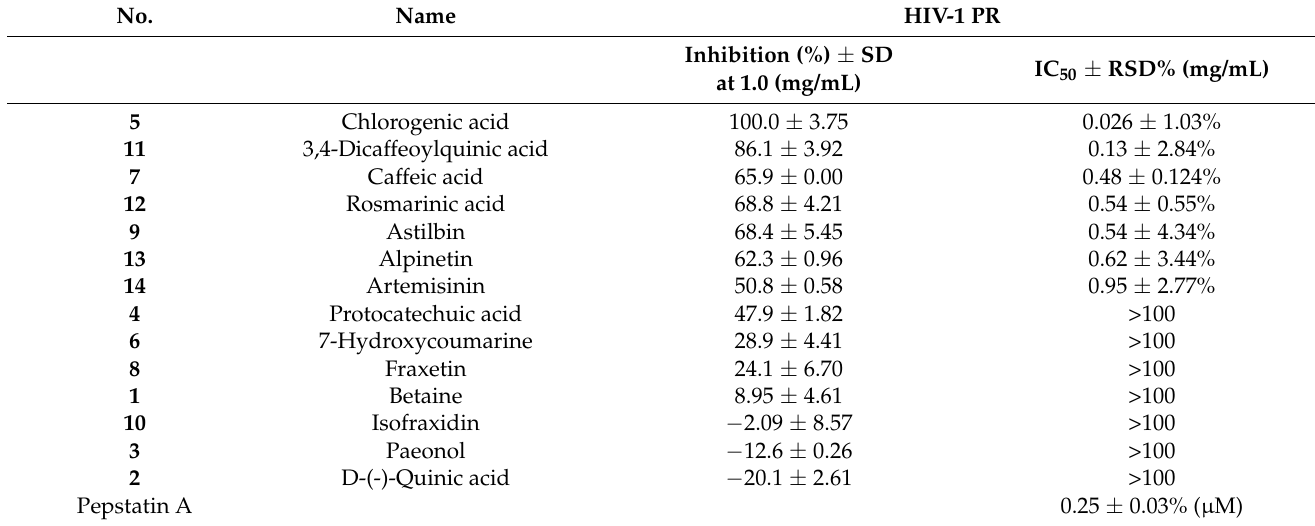
Table 4. Inhibition of HIV-1 PR by major ingredients of SG extracts ( n =